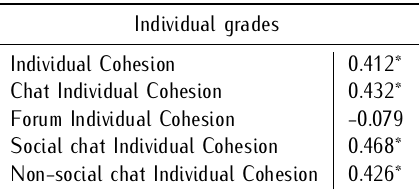
Table 6. Correlations between Individual cohesion measures and Individual grades. * p < 0 . 001